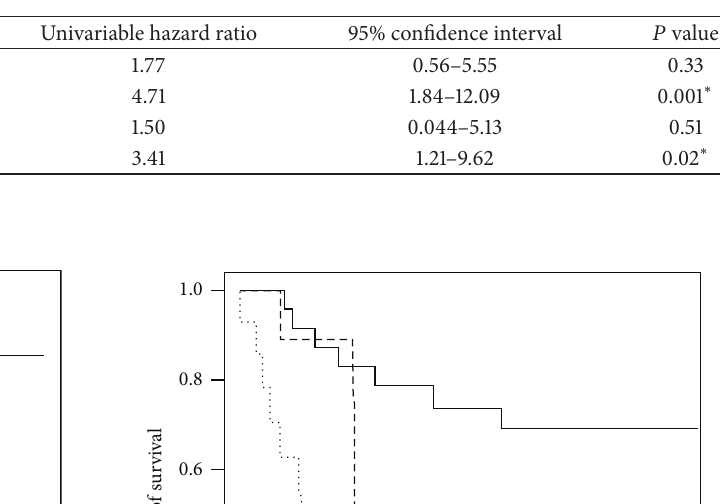
Statistically significant with 𝑃 < or = 0.05. Table 3: Hazard ratios for death compared to complete cytoreduction to no gross residual disease. Hazard Ratios demonstrating the association between the degree of cytoreduction and survival.